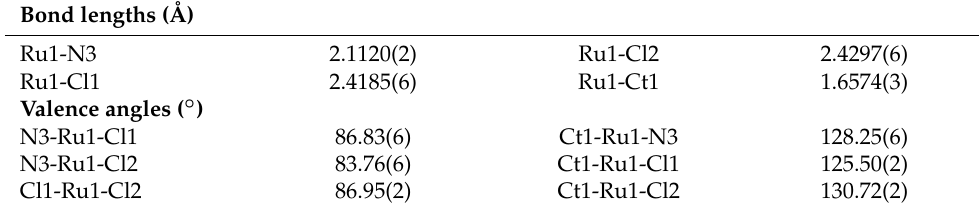
Table 3. Selected bond lengths (Å) and angles ( ◦ ) for complex 2